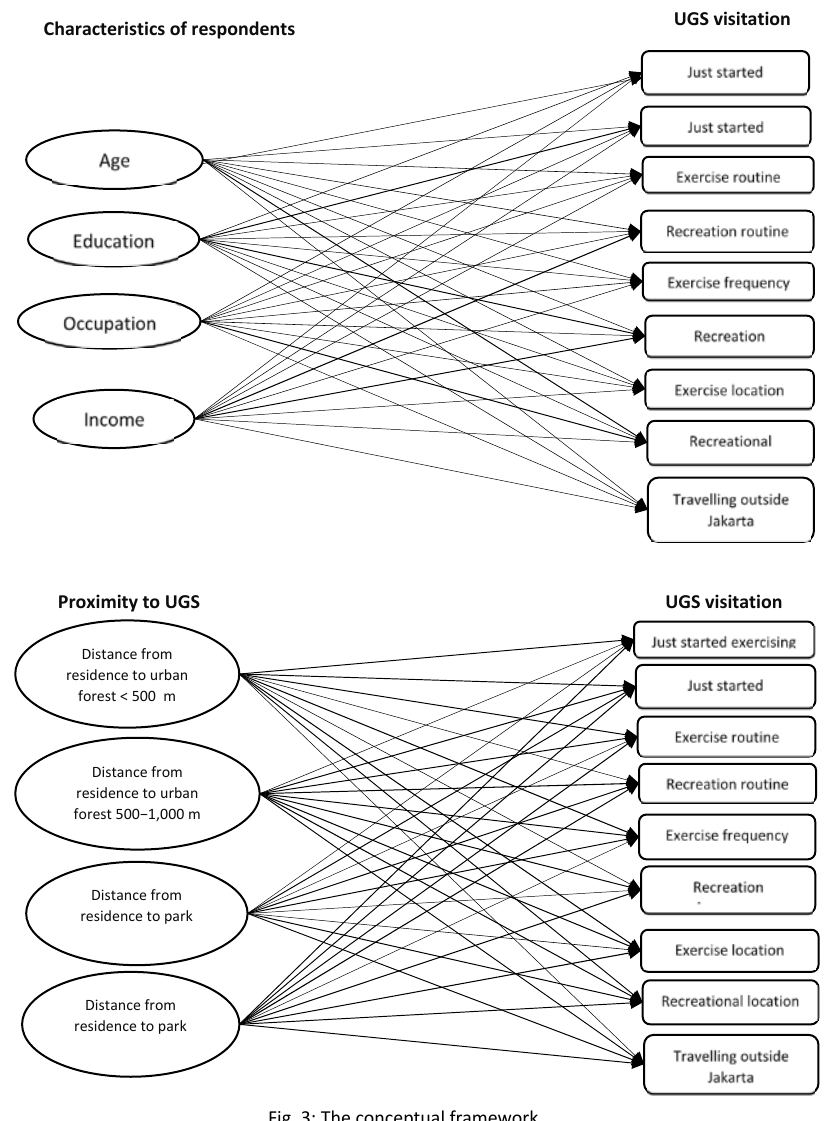
Fig. 3: The conceptual framework